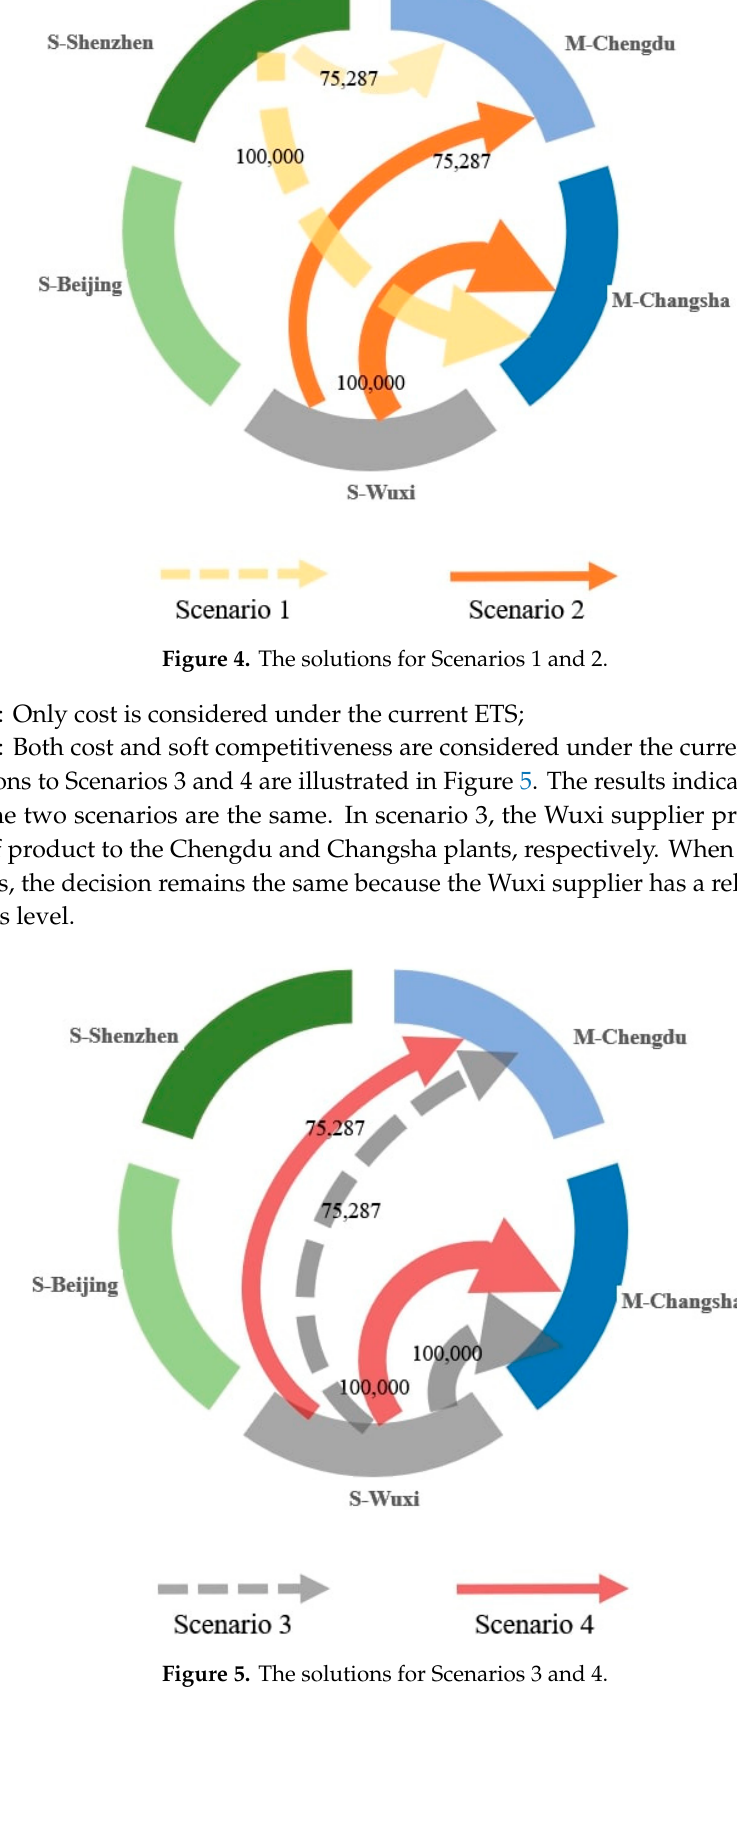
Figure 4. The solutions for Scenarios 1 and 2.